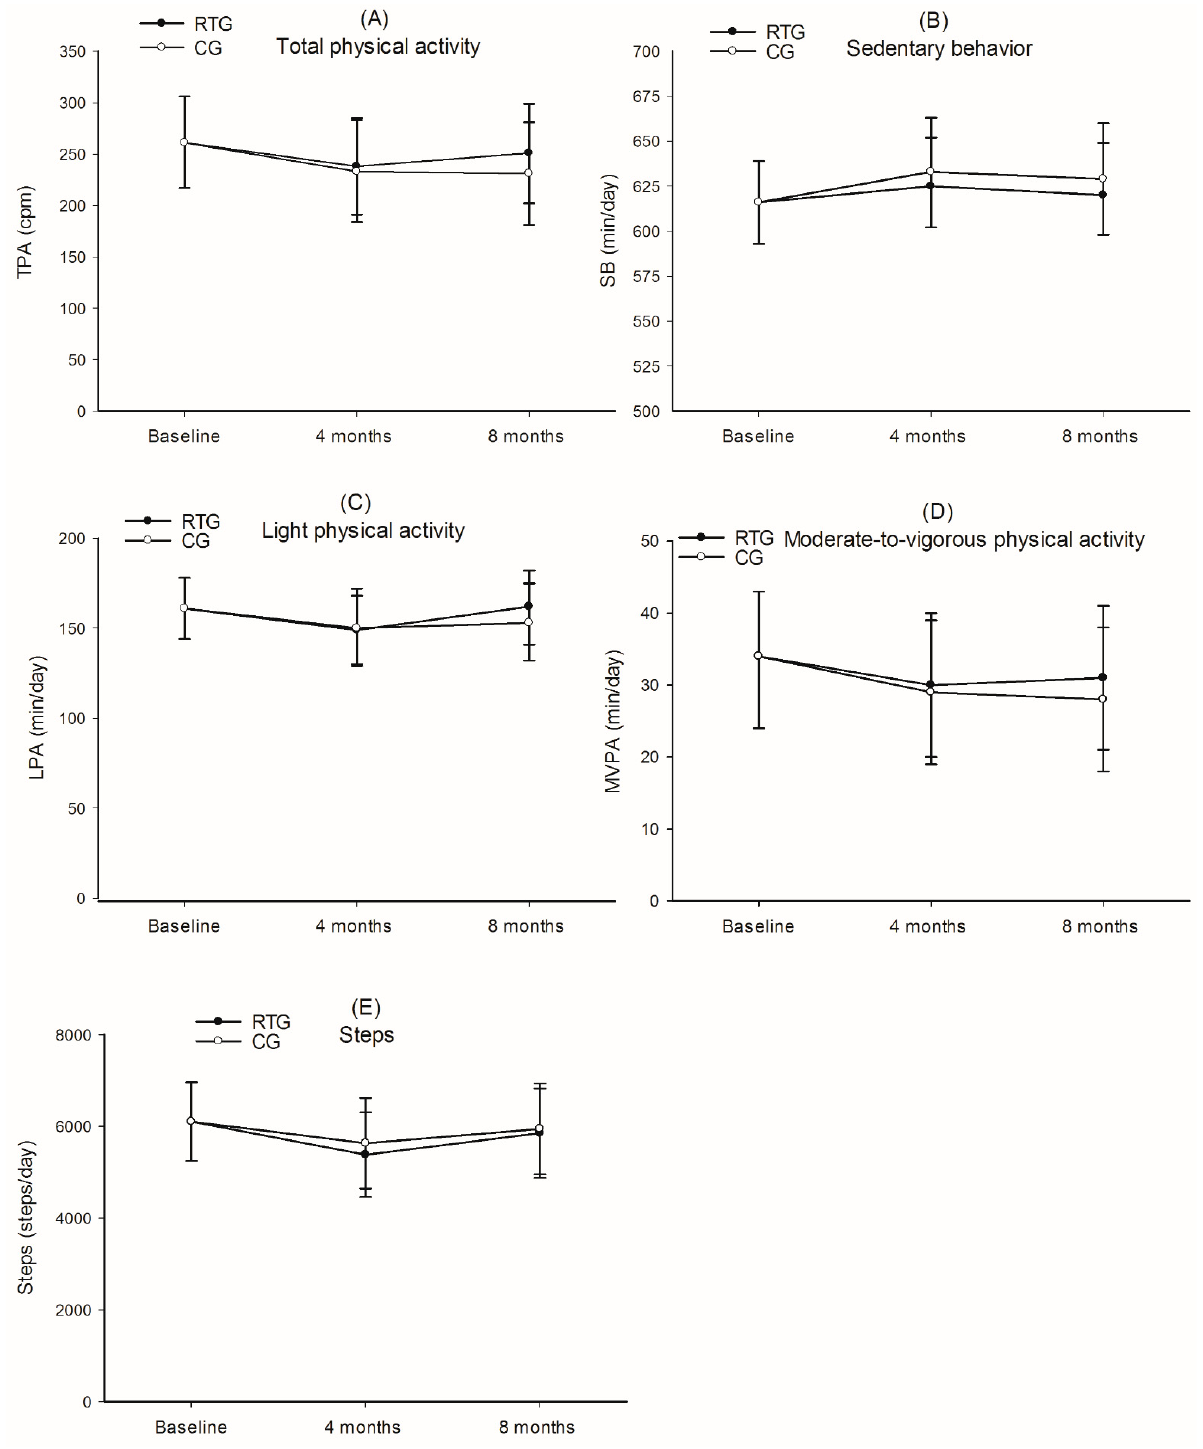
Figure 2. Changes in physical activity from baseline to four and eight months. Values are estimated means and 95% confidence intervals. RTG, resistance training group; CG, control group; Total PA, total physical activity; cpm, counts per minute; SB, sedentary behavior; LPA, light physical activity; MVPA, moderate-to-vigorous physical activity. ( A ) total physical activity, (TPA, cpm); ( B ) Sedentary behavior (SB, min/day); ( C ) Light physical activity (LPA, min/day); ( D ) Moderate-to-vigorous physical activity (MVPA, min/day); ( E ) Steps (steps/day).